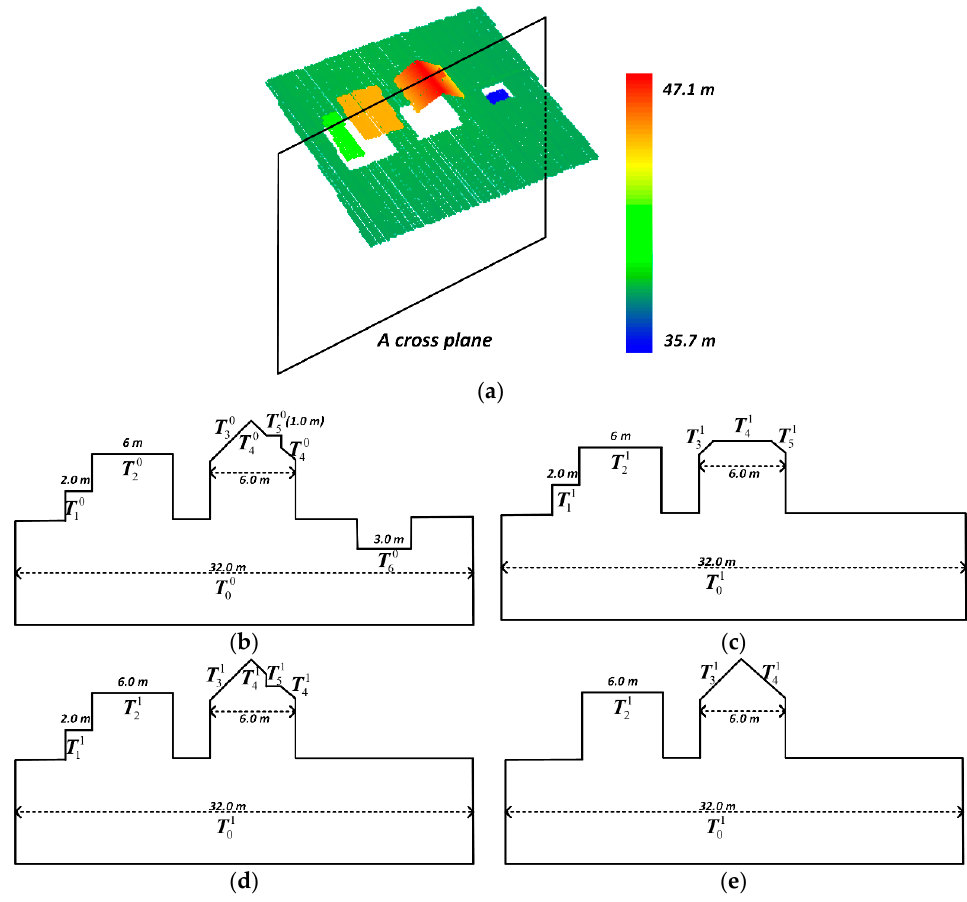
Figure 1. Improved morphological reconstruction for a building. ( a ) Raw point clouds of a building; ( b ) A cross-section of the raw point clouds, where the cross plane is illustrated in ( a ), and the width of each segment is annotated; ( c ) Result of morphological reconstruction at the scale of 2 m, where parts of the inclined roofs (cid:1846) (cid:2871)(cid:2868) and (cid:1846) (cid:2872)(cid:2868) are flattened; ( d ) Result of recovering the inclined segments (cid:1846) (cid:2871)(cid:2868) and (cid:1846) (cid:2872)(cid:2868) ; ( e ) Result of modifying false segments, where (cid:1846) (cid:2869)(cid:2869) and (cid:1846) (cid:2873)(cid:2869) are flattened onto the larger